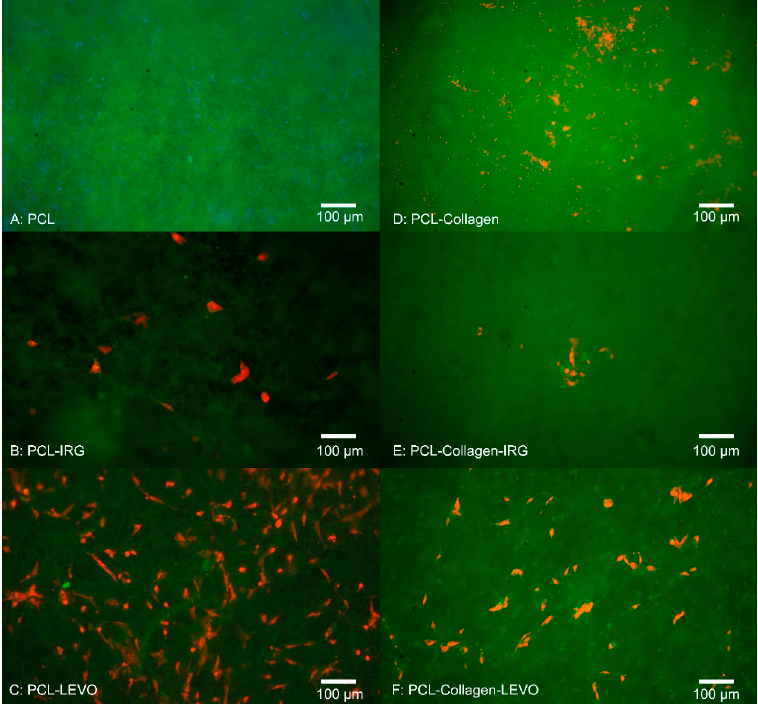
Figure 2. Fluorescent images of cell adhesion assay for rat aortic smooth muscle cells (RAOSMCs) after 3 days ( A ) PCL ( B ) PCL–irgasan (IRG) ( C ) PCL–LEVO ( D ) PCL–collagen ( E )